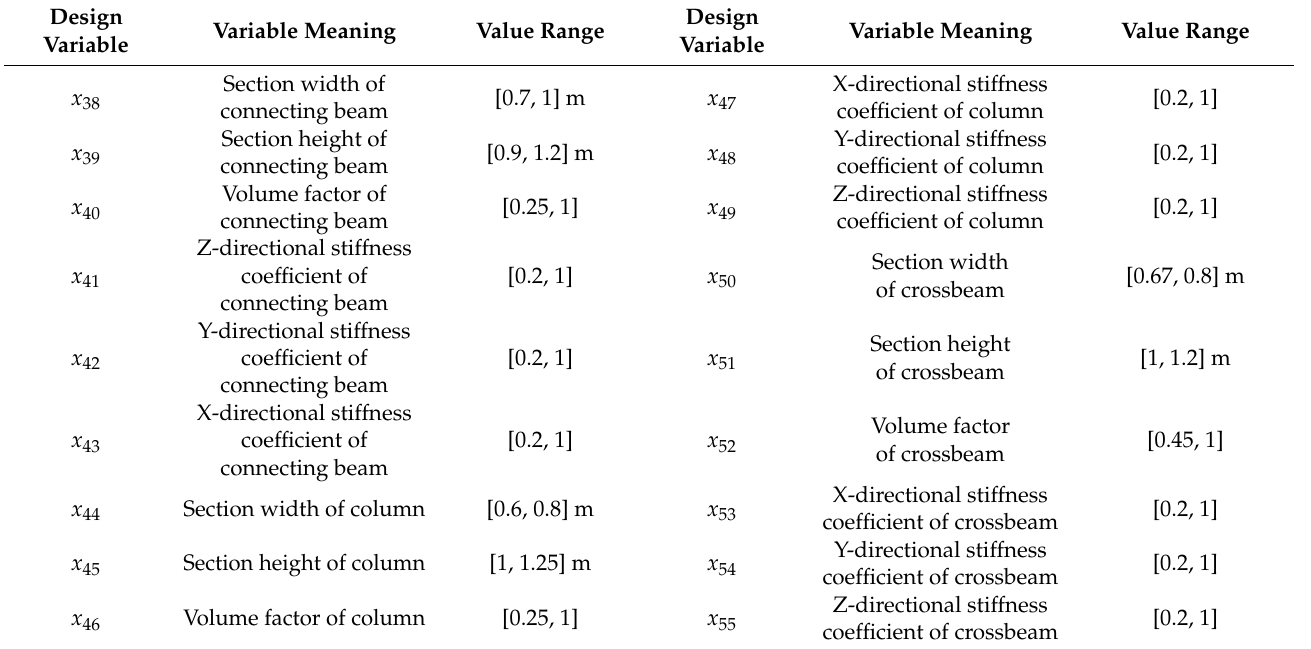
Table 3. Value range of structural design